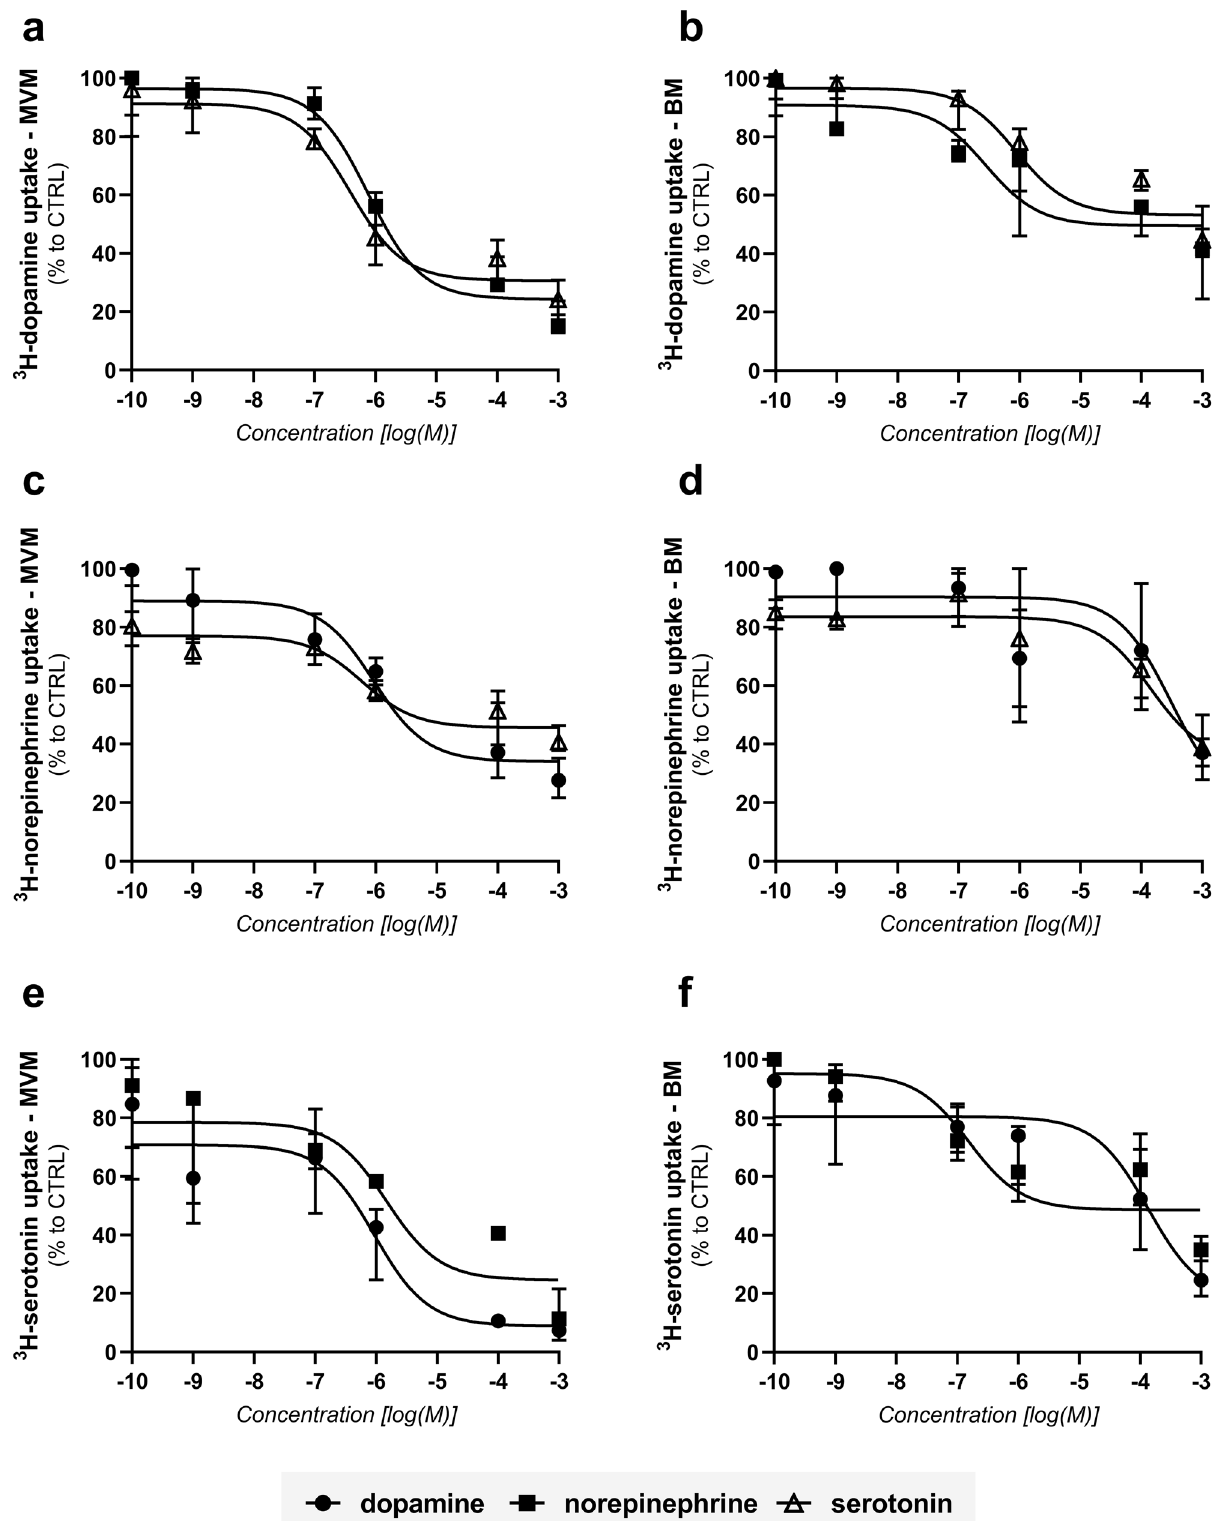
Figure 5. Effect of unlabelled dopamine, norepinephrine, and serotonin on monoamine transport systems in MVM and BM. Initial uptake rates (CTRL) were determined in vesicles incubated with 112 nM 3 H-dopamine ( a , b ), 332 nM 3 H-norepinephrine ( c , d ), and 100 nM 3 H-serotonin ( e , f ) at room temperature for 1 min. Concentration-dependent analyses of unlabelled monoamines were evaluated at a range of 0.0001–1000 µM. Curve fitting by nonlinear regression was implemented in GraphPad Prism 8.1. Results are presented as percent uptake relative to CTRL. Data are shown as median with interquartile range, n =